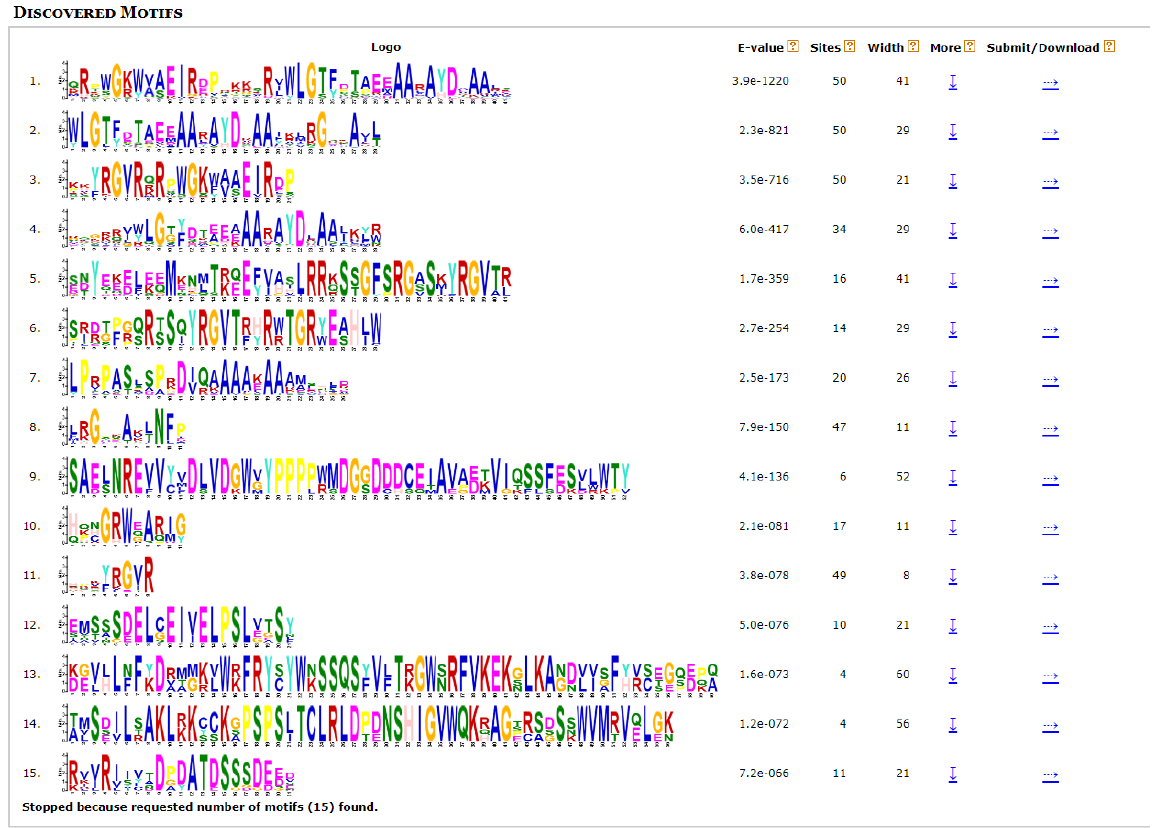
Figure 2. Fifteen main conserved motifs of RsAP2 genes .